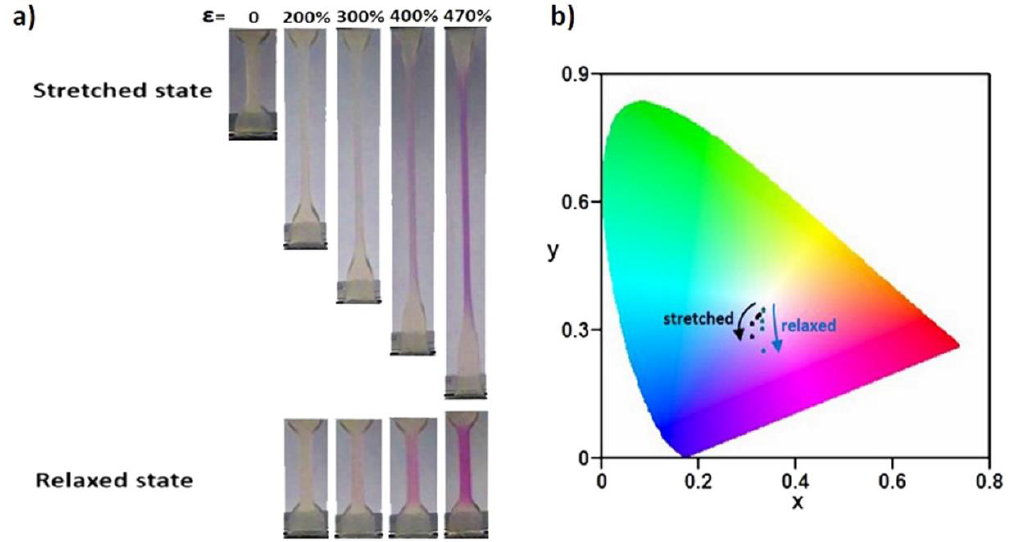
Figure 3. ( a ) Optical images of poly(AAm-co-MA/Rh) with a solid content of 70 wt% at both stretched state and the corresponding relaxed state. ( b ) The x, y chromaticity diagram for the color-change pathways of both stretched gels at loading state and relaxed gels at unloading state (standard CIE 1931). Note: ε means stretch ratio.